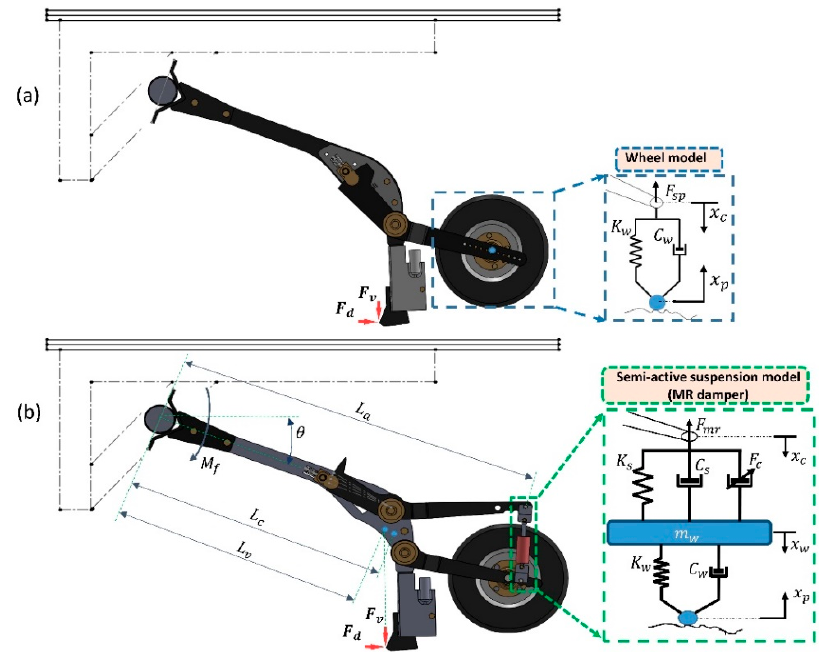
Figure 2. Representative view of ( a ) the original coulter assembly and ( b ) the assembly designed with the magnetorheological (MR) damping system.